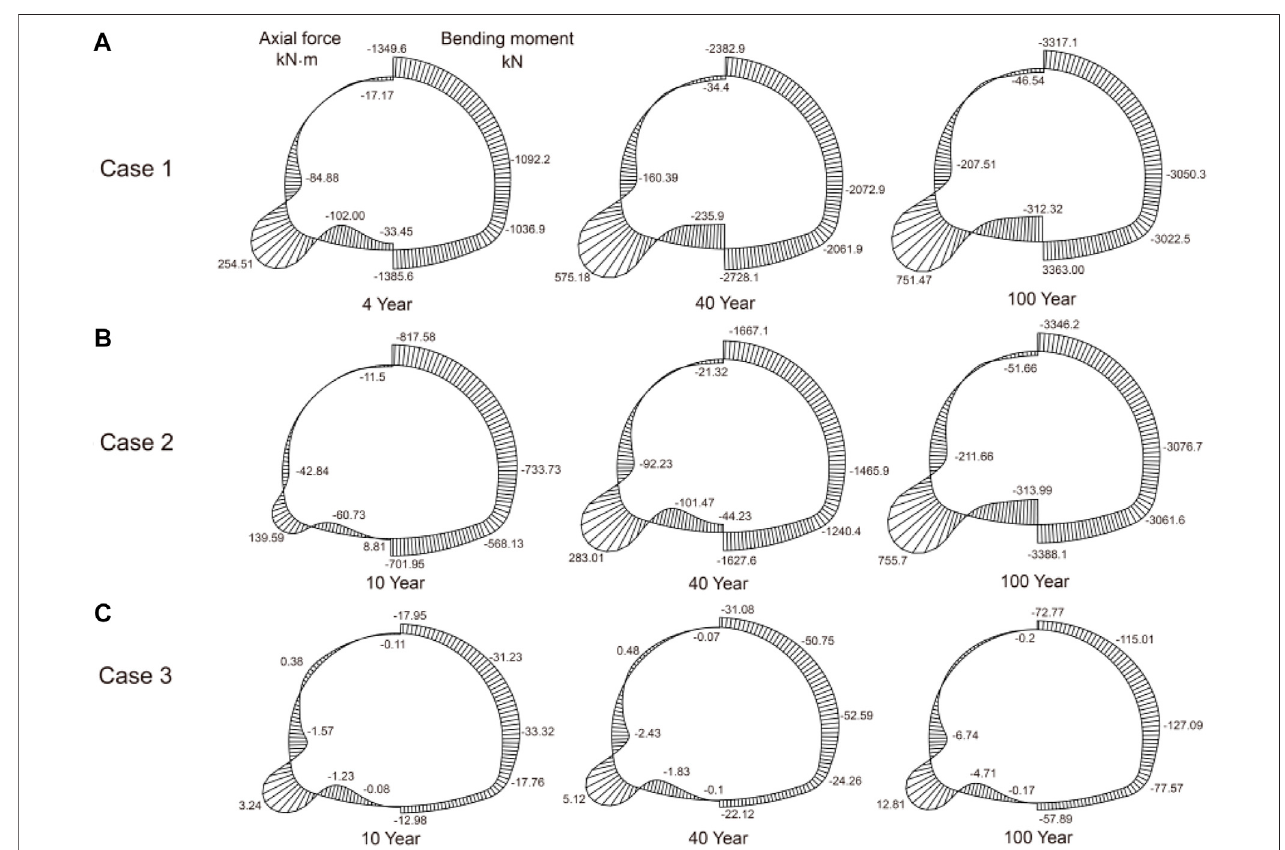
FIGURE 8 | Variations in internal force of the secondary lining with time. (A) Case 1. (B) Case 2. (C) Case